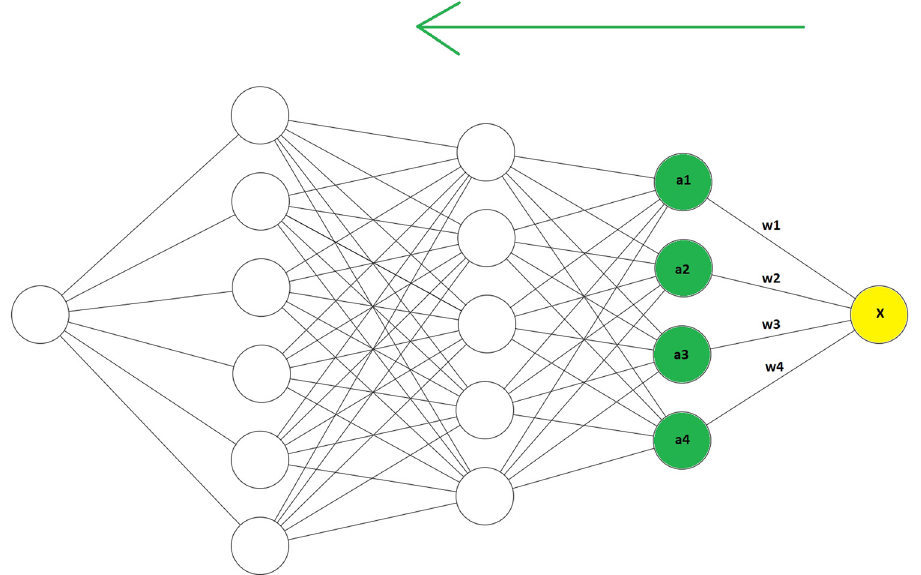
Figure 6: Backward iteration of neural